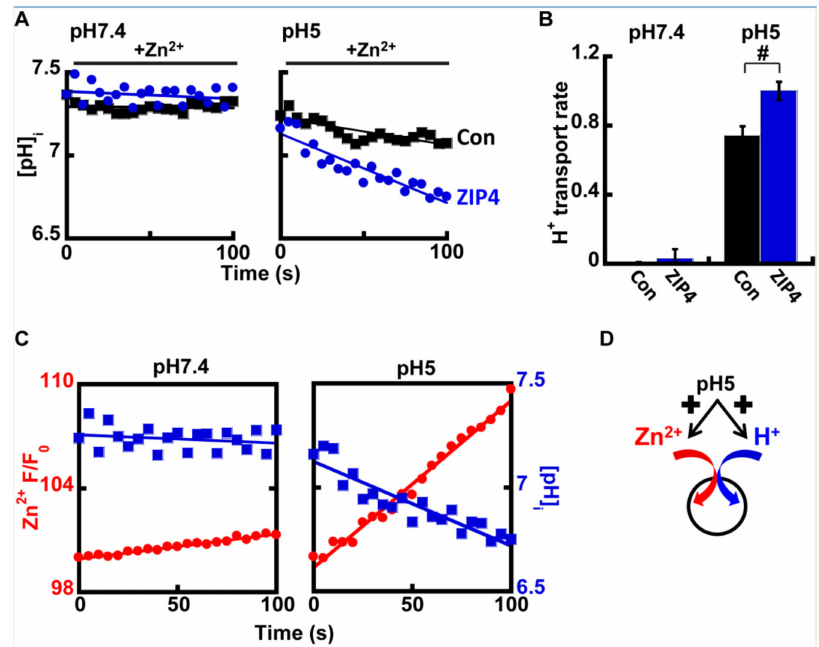
Figure 4. ZIP4 mediates H + coupled Zn 2 + transport. ( A ) Representative traces of HEK293-T cells transfected with ZIP4 (blue) or a control vector (black), loaded with 1 µ M BCECF-AM, and monitored for cytoplasmic pH changes at pH 7.4 (left) or pH 5 (right), following the addition of 50 µ M Zn 2 + . ( B ) Normalized H + transport rates recorded from control (black) or ZIP4 (blue) expressing cells, in the presence of 50 µ M Zn 2 + in the extracellular solution N ≥ 5. ( C ) Representative traces of Zn 2 + (red) and H + transport (blue), recorded with Fluozin-3AM and BCECF-AM accordingly. Note that H + uptake is parallel to Zn 2 + uptake. ( D ) Illustration of the suggested mechanisms of ZIP4. In (B), # is p ≤ 0.05 between control cells and cells expressing ZIP4 at pH